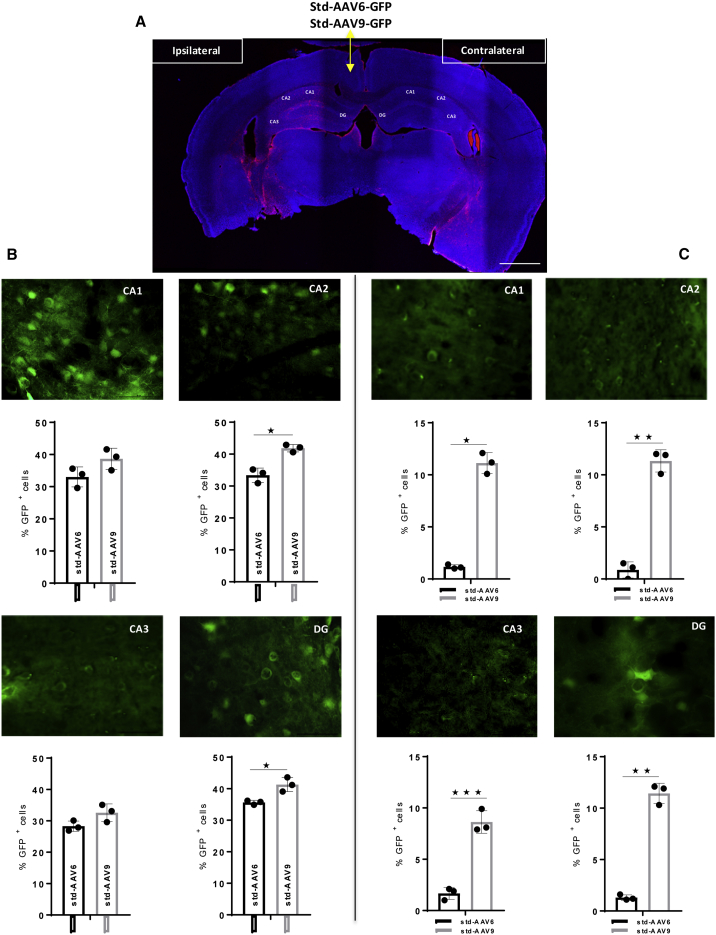
Quantification of std-AAV6-9-Mediated GFP-Positive Cells in the Contralateral Hippocampus(A) Representative coronal brain section showing GFP distribution after unilateral injection of std-AAV6-9 vectors (2 μL) into the ipsilateral hemisphere and PBS (2 μL) into the contralateral hemisphere of C57BL/6 mice. Images were captured by a Leica SP8 confocal microscope at 10× magnification. Scale bar 1 mm. (B) Quantification of GFP-positive cells visible enumerated in CA1, CA2, and CA3 and in DG in the ipsilateral hemisphere. CA2 (n = 3; p = 0.0236) and DG (n = 3; p = 0.0227). (C) Quantification of GFP-positive cells visible enumerated in CA1, CA2, and CA3 and in DG in the contralateral hemisphere. CA1 (n = 3; p = 0.0100), CA2 (n = 3; p = 0.0036), CA3 (n = 3; p = 0.0004), and DG (n = 3; p = 0.0029). Data were analyzed by an unpaired Student’s t with Mann-Whitney test and are expressed as percentages of GFP+ cells. Results were considered statistically significant with *p < 0.05 and levels of significance are indicated as follows: *p < 0.05, **p < 0.01, and ***p < 0.001. Data are presented as mean ± SEM. Images were by Leica DM6000 B fluorescence at 63× magnification. Scale bar 50 μm.